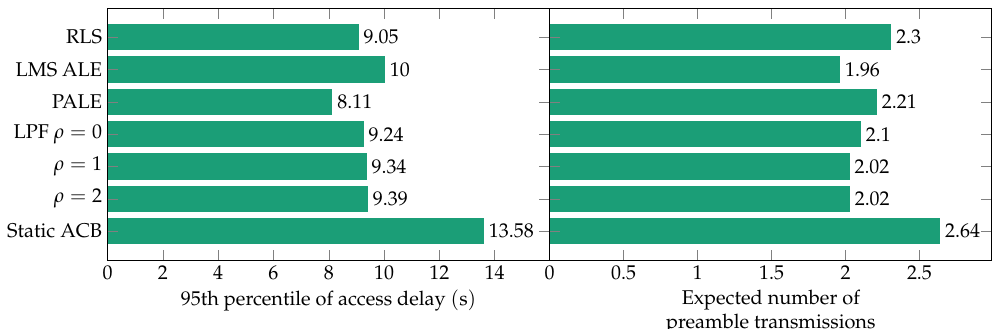
Figure 7. 95th percentile of access delay and expected number of preamble transmissions obtained with our ACBC scheme and with each of the studied filtering methods; the KPIs obtained with the optimal configuration of an ACB scheme with fixed parameters (static ACB) are also included. The success probability for these is higher than